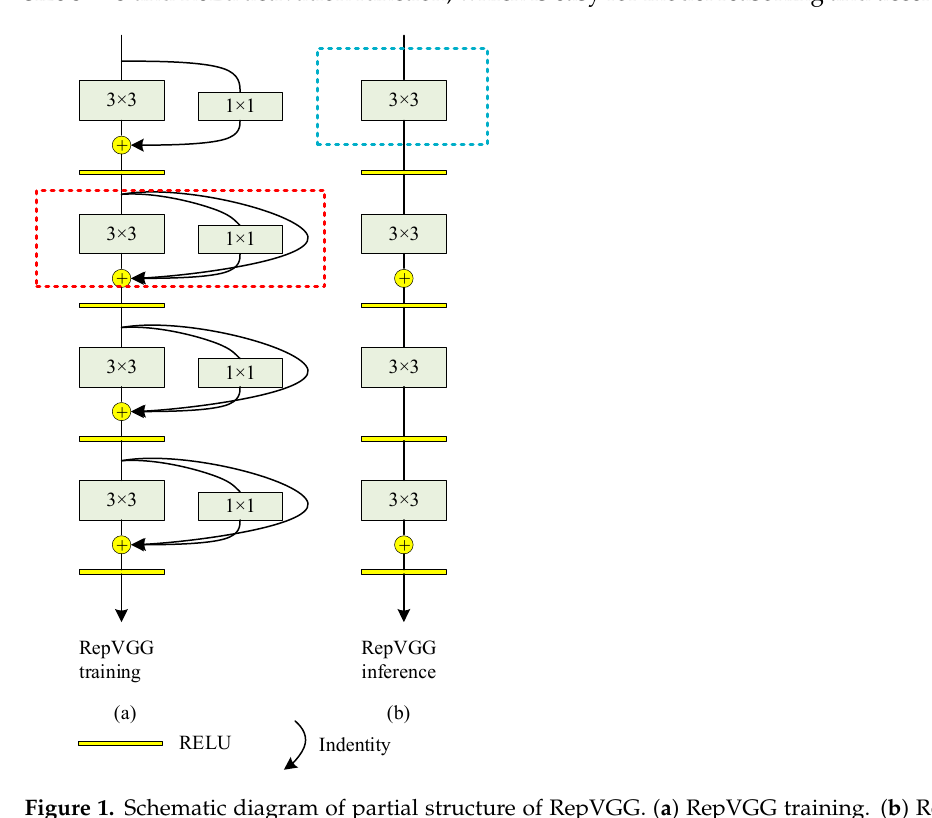
Figure 1. Schematic diagram of partial structure of RepVGG. ( a ) RepVGG training. ( b ) RepVGG inference.